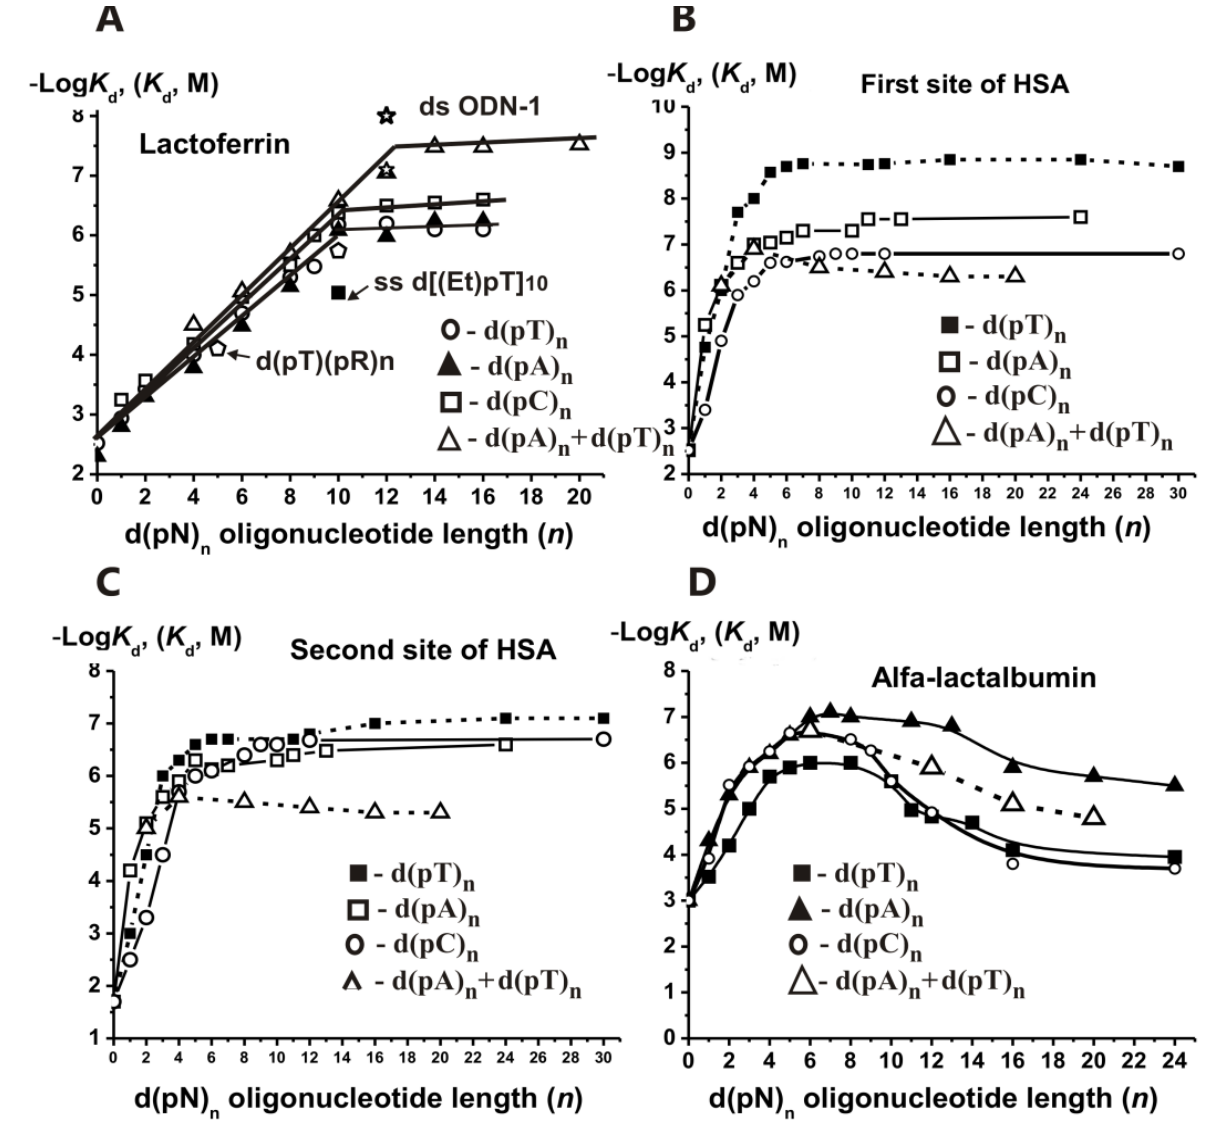
Figure 16. Dependencies of − Log K d for ss and ds d(pN) n deoxyribooligonucleotides versus their length ( n ) in the case of human lactoferrin ( A ) [124], first ( B ), and second ( C ) DNA-binding sites of human albumin [125], and human α -lactalbumin ( D ) [126]. All types of enzymes and ODNs are shown on the Panels; d(pT)(pR) n oligomers contain only one T base, d[(Et)pT] 10 is oligonucleotide with ethylated internucleoside phosphate groups. LF interacts with the specific sequence of ds DNAs and activates transcription TAGAA- GATCAAA (ODN1; Figure 16A) [121]. The affinity of ss 12-mer ODN1 ( K d = 8.0 × 10 − 8 M) was 4.0–7.9-fold higher than different unspecific ss 12-mer ODNs ( K d = (3.2–6.3) × 10 − 7 M), while ds ODN1 ( K d = 1.0 × 10 − 8 M) demonstrated nine-fold higher affinity than ds